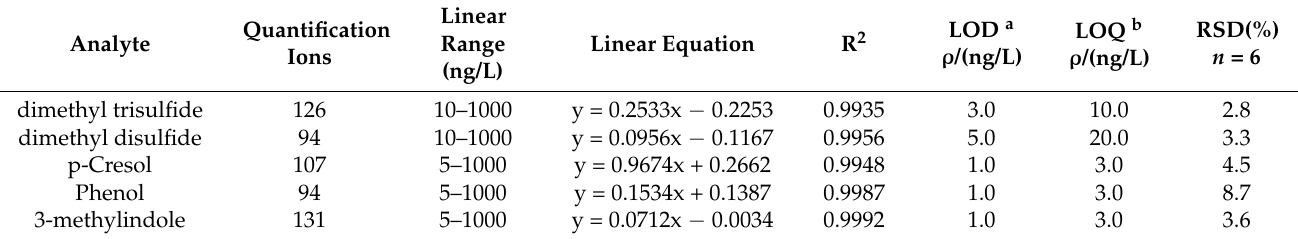
Table 1. Linear equation, correlation coefficient, limit of detection and RSD of the method.